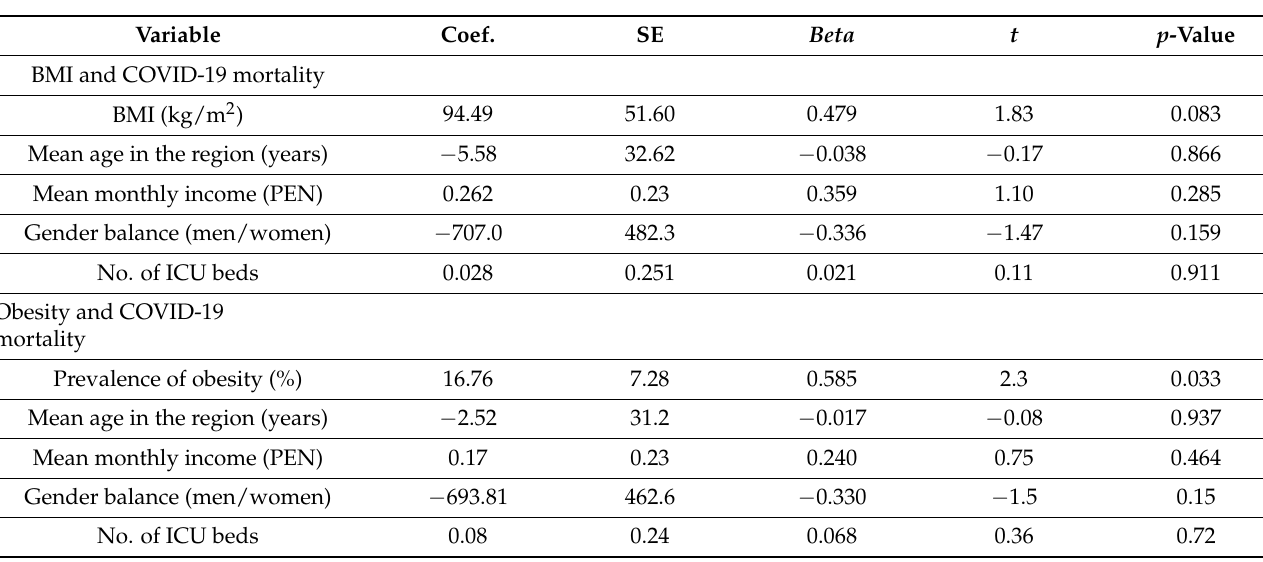
Table 2. Multiple regression analysis of prevalence of obesity and COVID-19 mortality